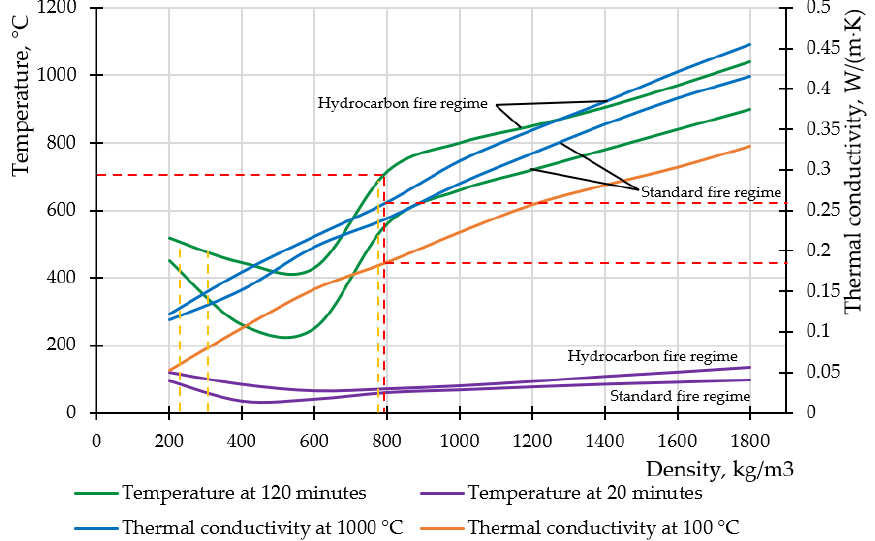
Figure 18 . Calculated values of temperature and thermal conductivity depending on the density of plaster compositions.